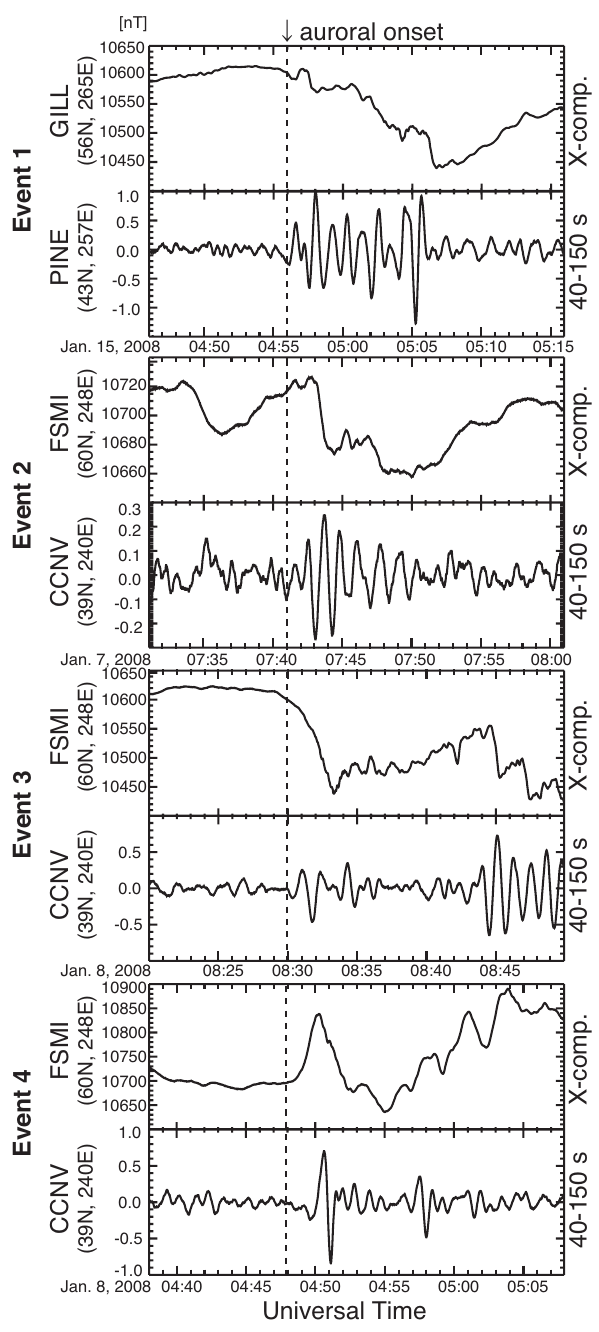
Fig. 1. X-component magnetic field variations observed at auro- ral onset sites and X-component filtered magnetic field fluctuations in the Pi2 range (periods ∼ 40–150s) observed at mid-latitude sites during the 4 events of auroral initial brightenings reported in this pa- per. Vertical dashed line indicates the onset time of auroral bright-